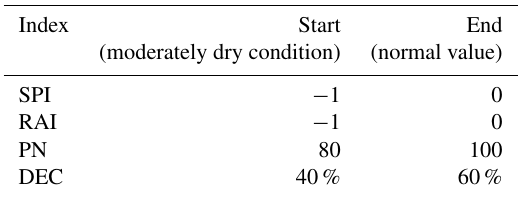
Table 6. Values of the thresholds defining the start and the end of the drought events for each